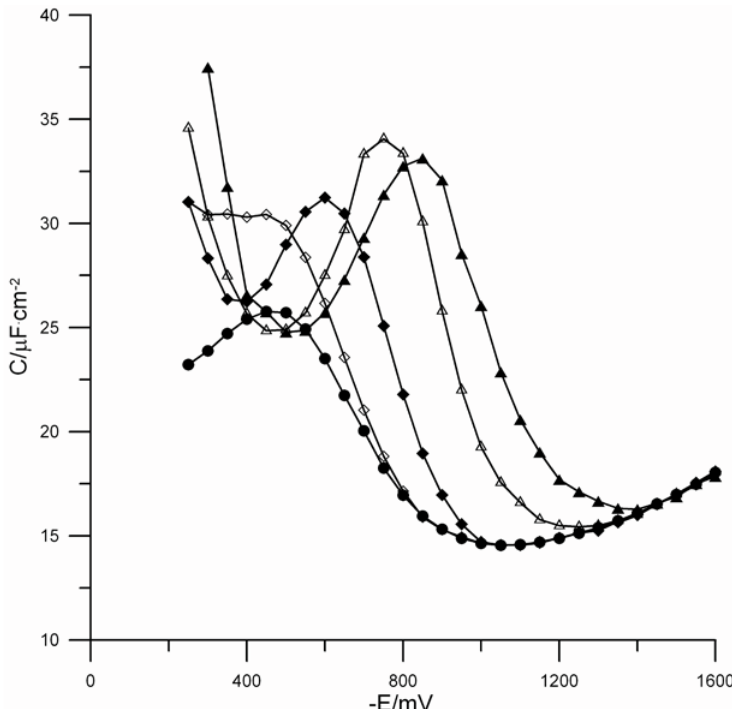
Figure 1. The differencial capacity curves of double layer interface Hg/1 mol dm -3 NaClO 3×10 -3 mol dm -3 TU ( ◊ ) [ 33], MTU ( ♦ ), ATU ( Δ ) [ 35] and DMTU ( ▲ ) [